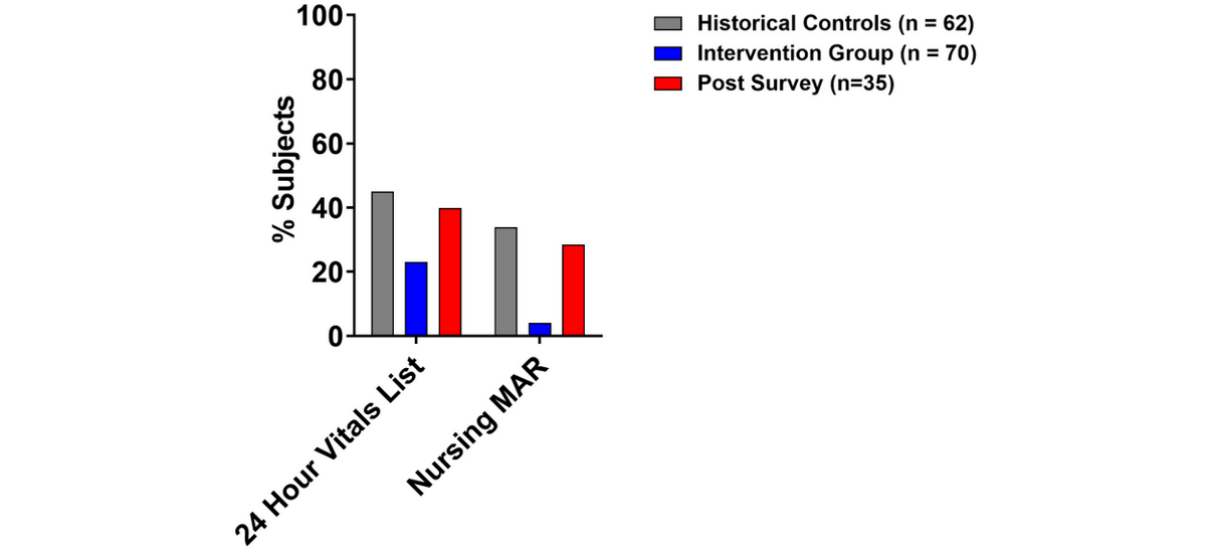
Figure 5. Percentage of reference subjects and intervention interns using low-yield screens and participant self-reported use of low-yield screen 6 months after the intervention. The reference residents (N=62) and intervention interns with available data (n=70, 99%) had data gathering navigation patterns during the independent learning portion of the simulation recorded. Intervention participants used low-yield screens less frequently than historical controls by Pearson chi-square ( P <.05). Intervention interns responded to a survey querying continued use of high-yield screens 6 months after the lesson (n=35, 50%); decreased use of low-yield screens was not sustained. I/O: Intake/output; ICU: intensive care unit; MAR: Medication Administration